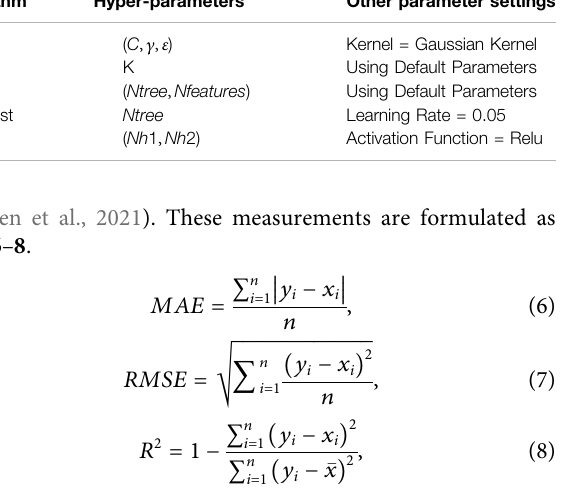
TABLE 2 | Hyper-parameters optimization. Algorithm